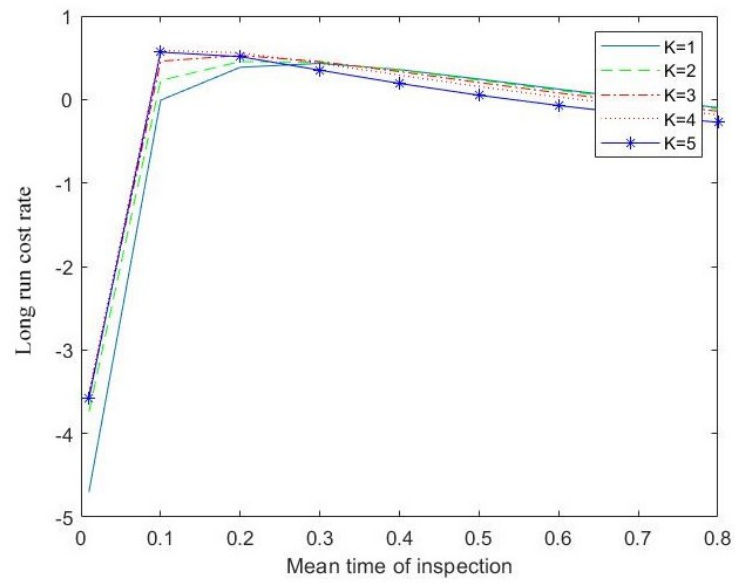
Figure 7. The long-run cost rate in terms of µ I for different values of K .